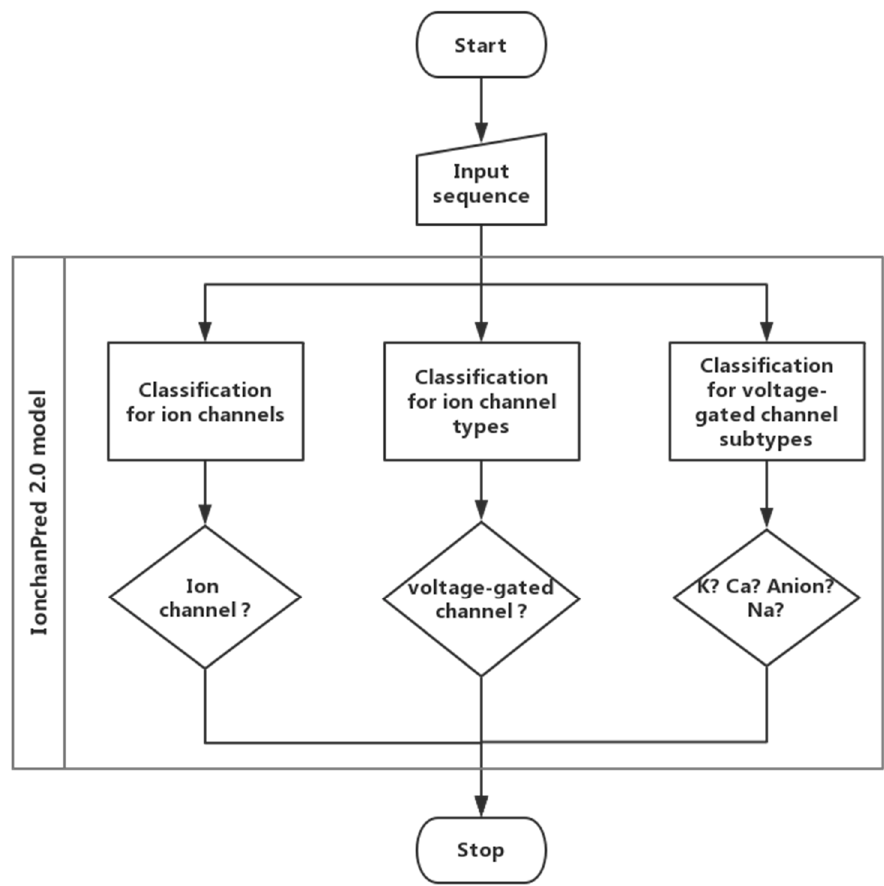
Figure 2. Workflow of the IonchanPred 2.0 model.